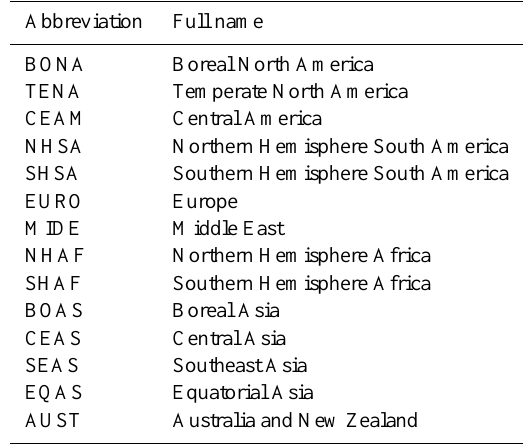
Table 1. List of GFED regions and abbreviations (Giglio et al.,